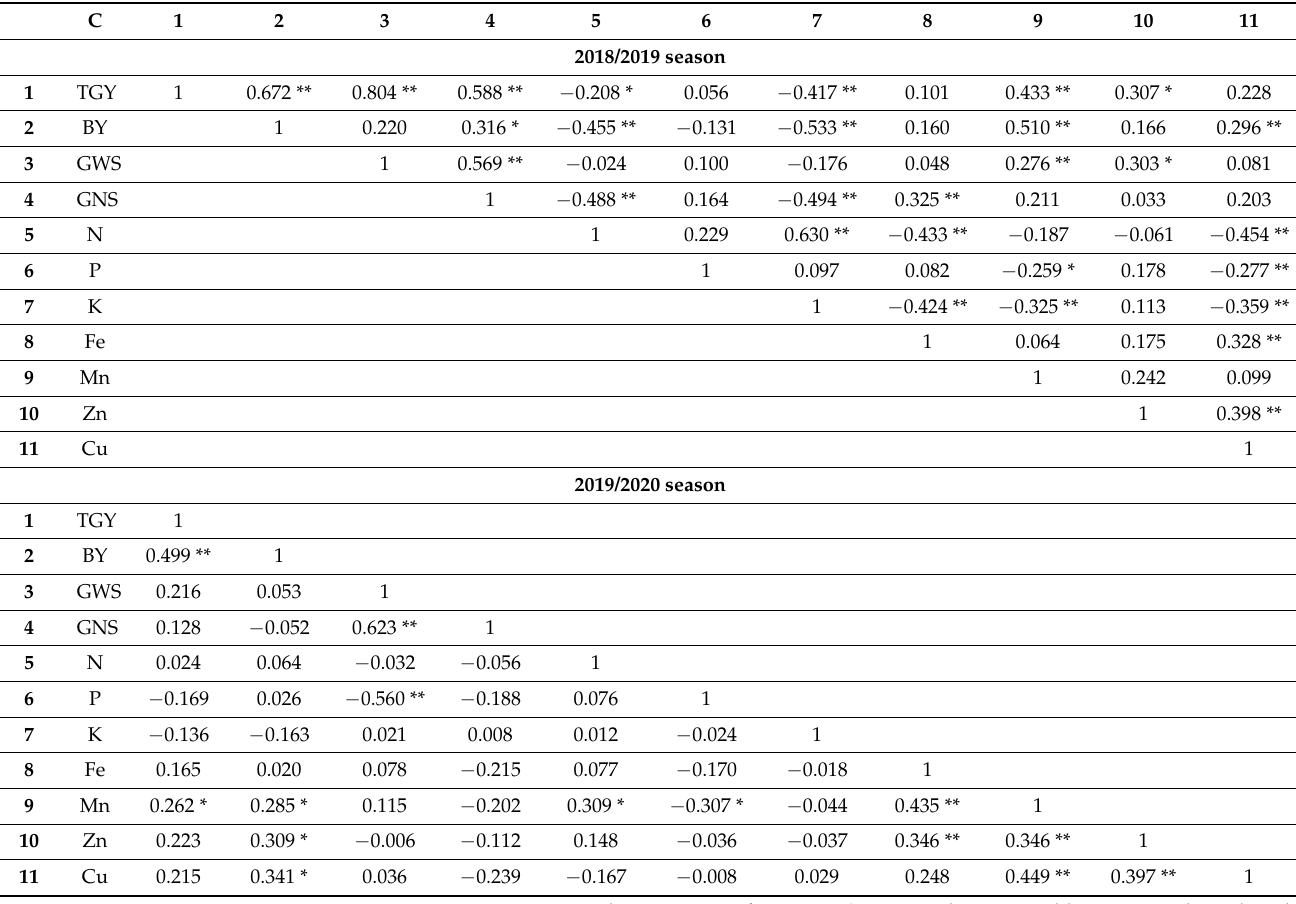
Table 10. A matrix of linear correlation coefficients and their significance levels between total grain yield (TGY, t ha − 1 ) and other important attributes and nutrients of some wheat varieties grown in clay loam soil in 2018/2019 and 2019/2020